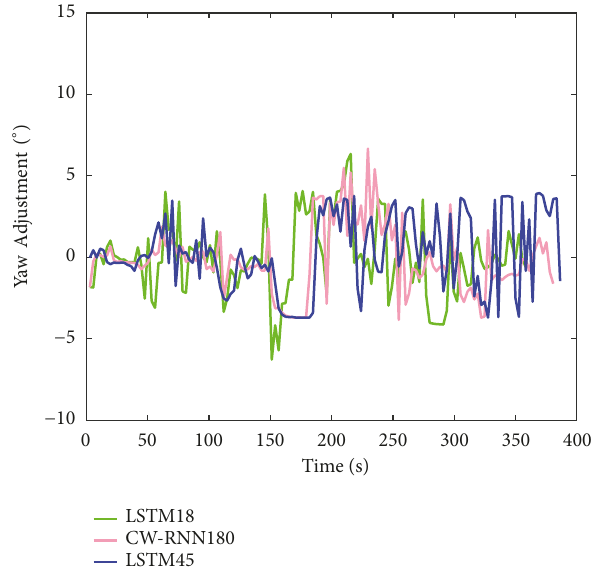
Figure 14: Curves of yaw adjustment output by the several obstacle avoidance algorithms in simulation test case